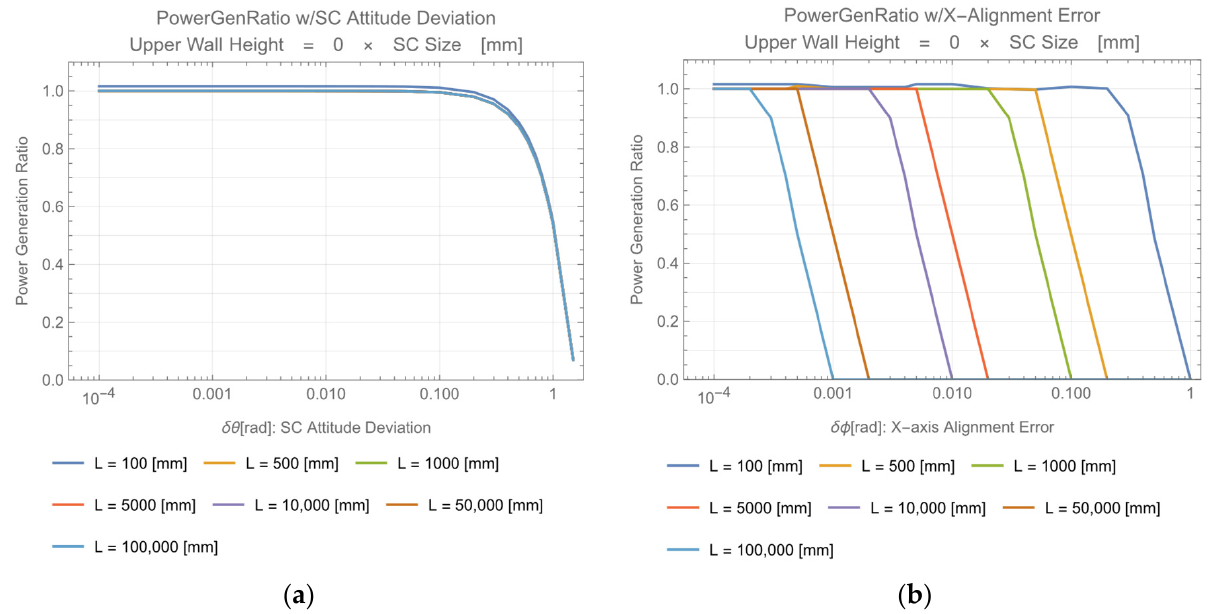
Figure 15. Beam Energy Confinement by Lower Wall Mirror: ( a ) power generation ratio calculation for the tilt angle relative to the beam; ( b ) for the X(Y) deviation of the beam. In the configuration of Figure 14, where upper wall height = SC (solar cell array size), the power generation ratio is calculated for solar cell array attitude deviation (Figure 16a) and X(Y) axis angle deviation (Figure 16b).